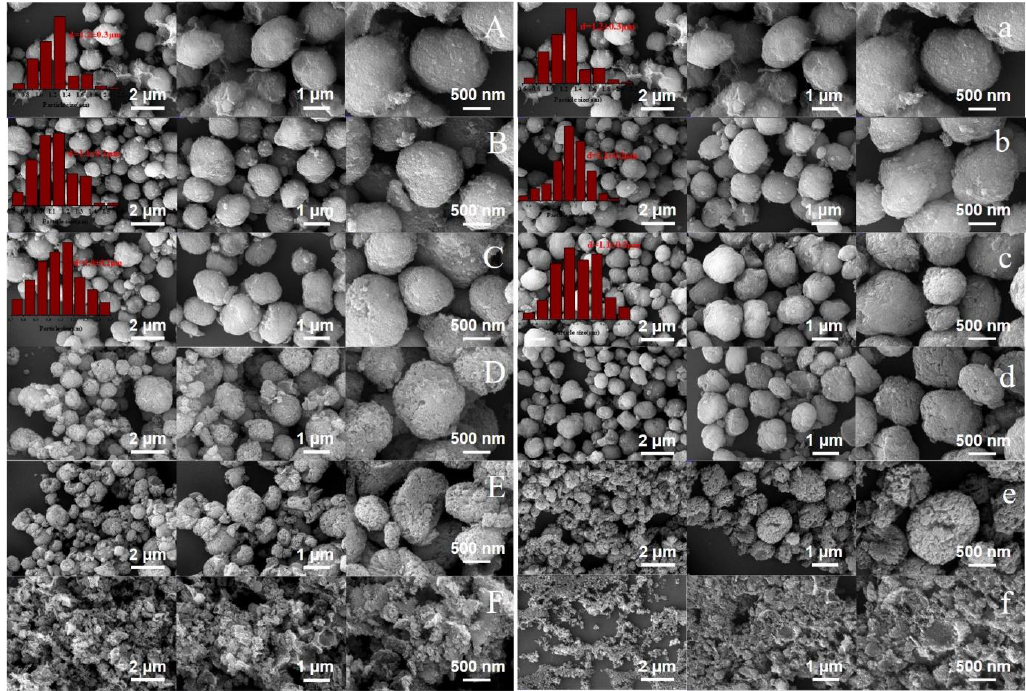
Figure 3. SEM images of ( A ) FMTP-2P; ( B ) 4 mol/L HCl; ( C ) 4 mol/L HCl + 0.1 mol/L NaOH; ( D ) 4 mol/L HCl + 0.2 mol/L NaOH; ( E ) 4 mol/L HCl + 0.4 mol/L NaOH; ( F ) 4 mol/L HCl + 0.8 mol/L NaOH. SEM image of ( a ) FMTP-2P; ( b ) 4 mol/L H 2 C 2 O 4 ; ( c ) 4 mol/L H 2 C 2 O 4 + 0.1 mol/L NaOH; ( d )